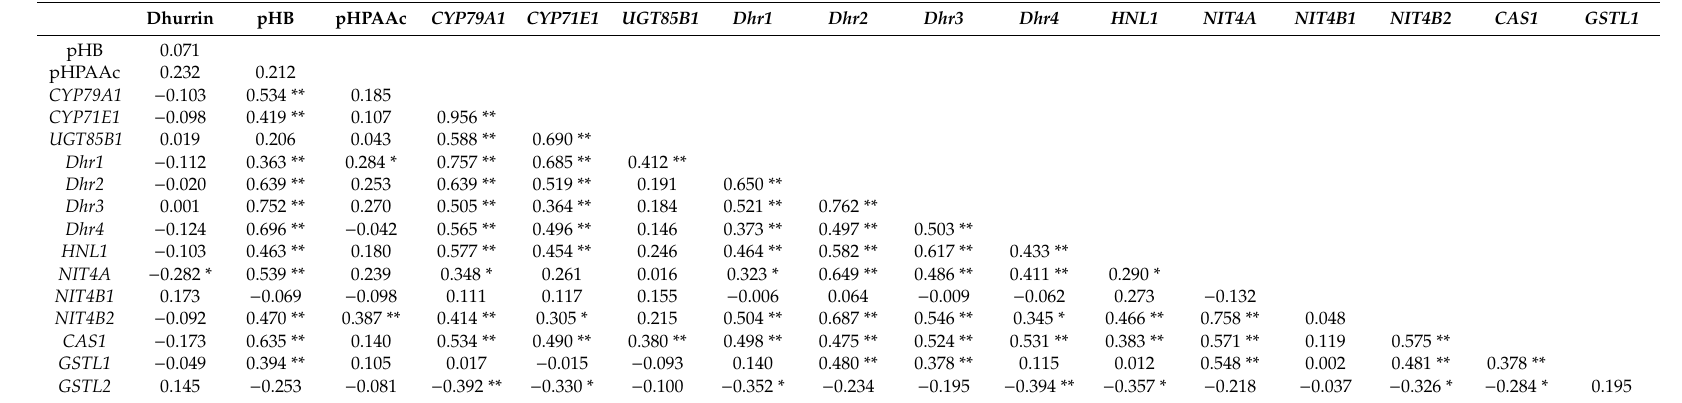
Table 1. Pearson’s correlation coe ffi cients of metabolite contents and gene expression